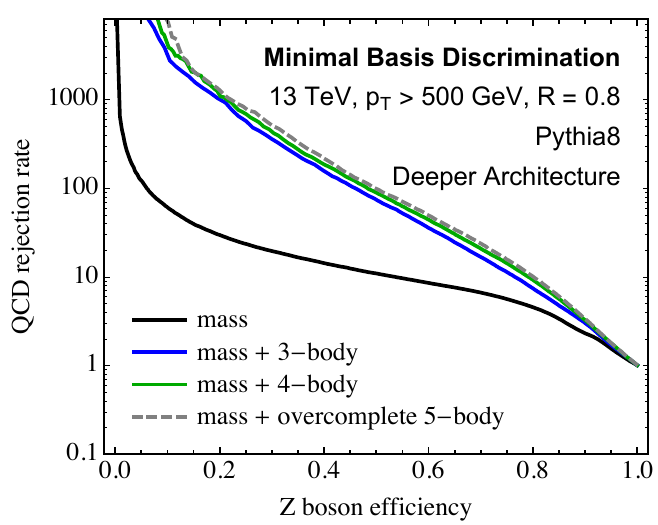
Figure 12. Signal e(cid:14)ciency versus background rejection rate for jet mass plus the overcomplete basis of observables that are sensitive to 5-body phase space described in the text, as determined by the deeper neural network. For comparison, we also include the signal e(cid:14)ciency versus background rejection rate for jet mass, jet mass plus minimal 3-body phase space observables, and jet mass plus the minimal 4-body phase space observables.